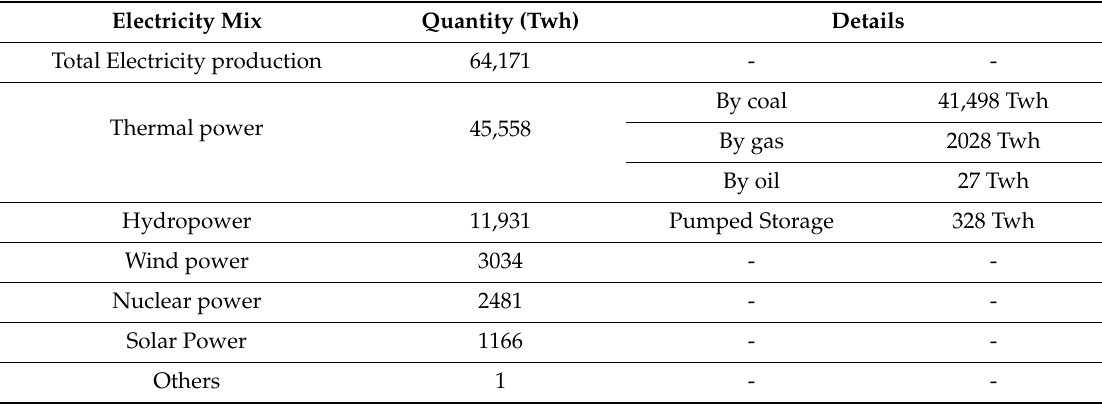
Table 4. The electricity mix in China